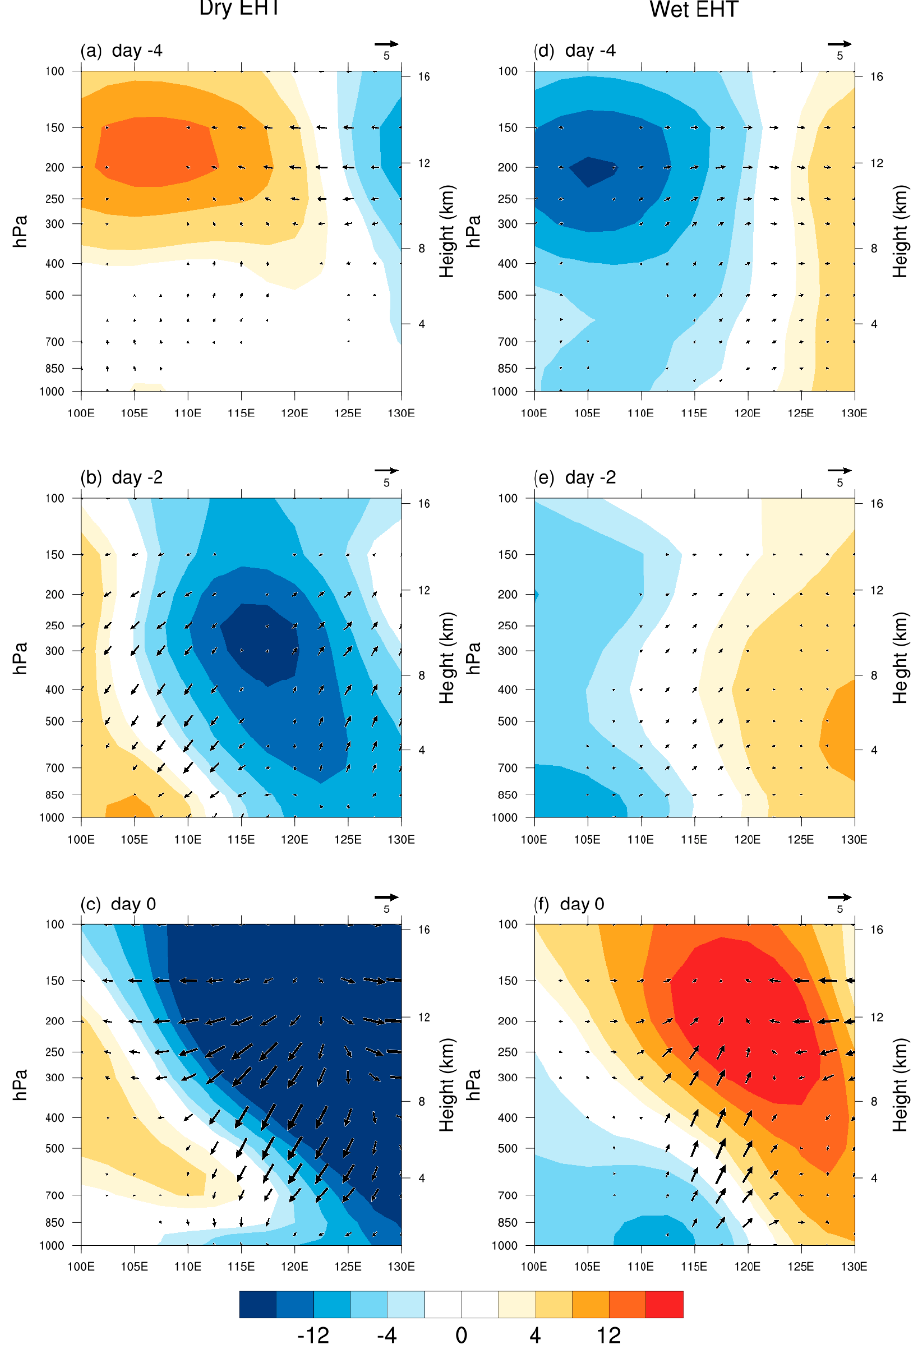
Figure 3. Vertical cross-sections of GPH anomalies (shadings; unit: gpm) and zonal vertical velocity (vector; vertical velocity; unit: pa/s, scale 100 pa/s; zonal wind; unit: m/s) averaged from 32.5 ◦ to 40 ◦ N from day − 4 to onset day for dry EHT days ( a – c ) and wet EHT days ( d – f ).